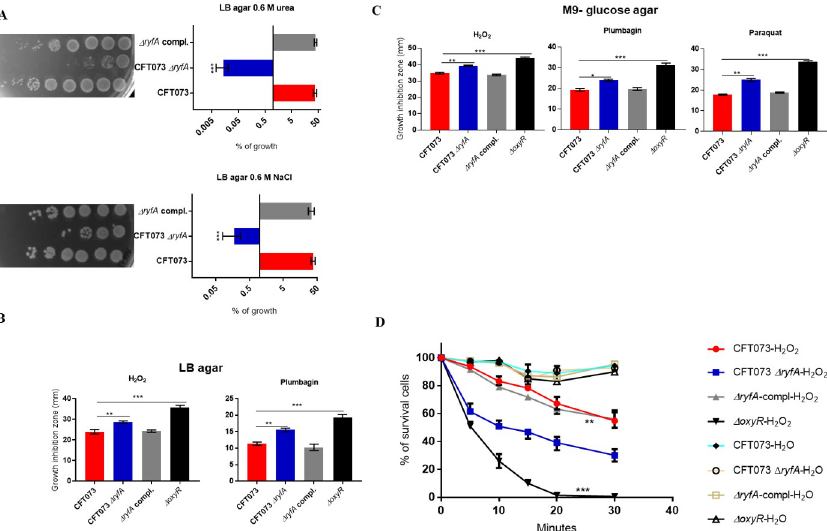
Fig 1. Role of RyfA in osmotic and oxidative stress resistance. ( A ) Growth under conditions of osmotic stress. Strains were grown shaking in LB medium until mid-log phase (O.D. 600 , 0.6) and plated on LB agar and LB agar with 0.6 M NaCl and 0.6 M urea (see Methods). ( B ) Growth inhibition zones (mm) of UPEC CFT073, ryfA mutant and complemented strains to oxidative stress generating compounds. Strains were grown on either LB agar or ( C ) M9- glucose agar. ROI-generating compounds tested were 30% hydrogen peroxide (H 2 O 2 ), 53 mM plumbagin, or 40 mM paraquat. ( D ) Resistance to hydrogen peroxide in LB broth. WT CFT073 and ryfA mutant strains were examined in LB medium containing 5mM H 2 O 2 or an equivalent volume of Milli-Q water (H 2 O). Samples were collected every 5 minutes, diluted, and plated on LB agar to determine CFUs. The CFT073 Δ oxyR strain was used as a sensitive control strain. The results represent the means of replicate experiments for a minimum of three samples. Vertical bars represent the standard errors of the means. Statistical significance was calculated by one-way ANOVA (A to D): ( � , P < 0.05; �� , P < 0.005; ��� , P < 0.0001).